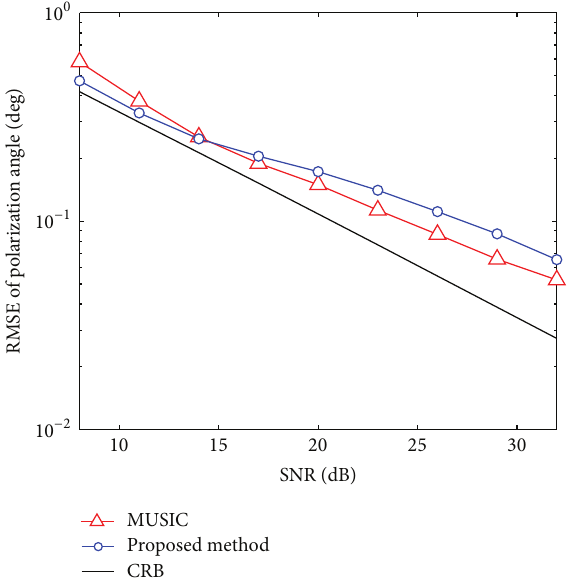
Figure 9: RMSE of the polarization angle for the strong source versustheSNRoftheweaksource,wherethestrongsourceislocated at (𝜃 1 , 𝛾 1 ) = (3 ∘ , 30 ∘ ) with SWR = 20 dB and the weak source is located at (𝜃 2 ,𝛾 2 ) = (7 ∘ , 35 ∘ ) .